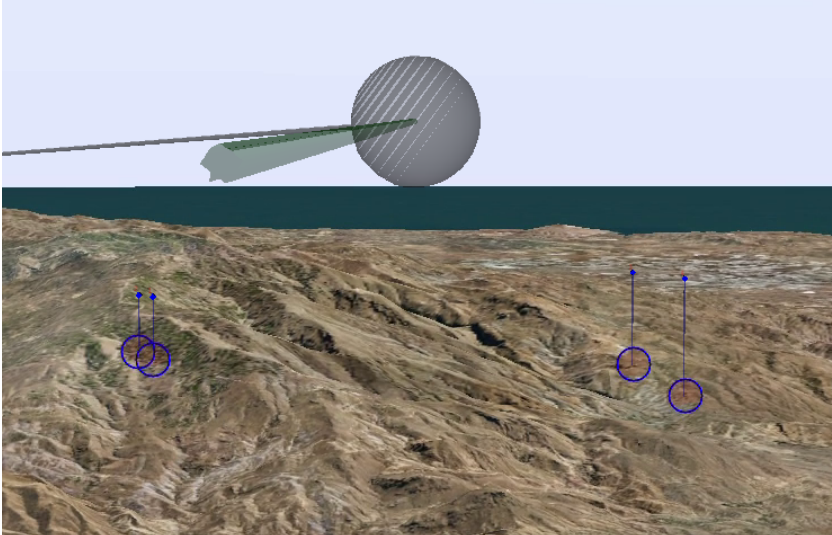
Figure 8. Augmented video with highlighted route (waypoint and legs) and four targets. Same notation for virtual targets as in Figure 7. Same notation for waypoints and legs as in Figure 6: the camera is looking at the last visited waypoint (hence, it is colored in grey, as in Figure